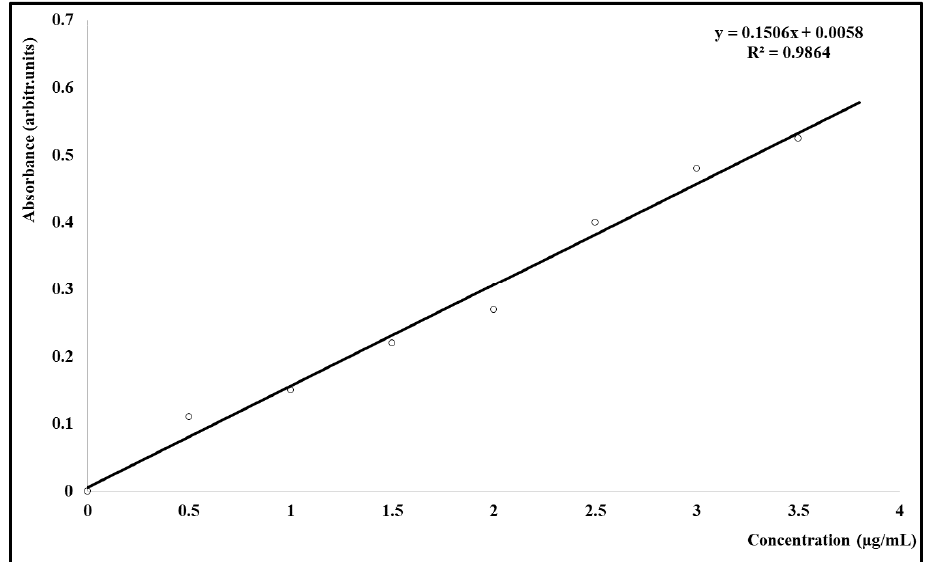
Figure 3. The calibration curve for curcumin (Cc). Table 2. Experimental values of the Zetasizer